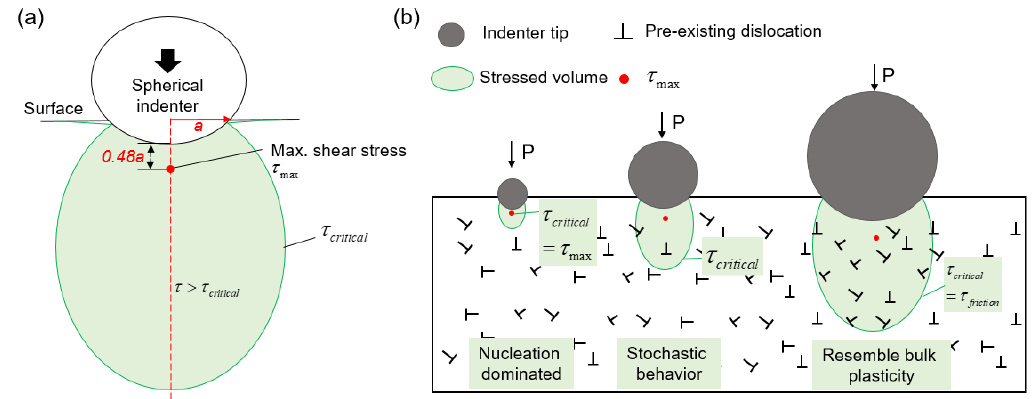
Figure 6. Schematic illustration of ( a ) the maximum shear stress and the critical shear stress under a spherical indenter; ( b ) effect of the defect population with respect to the volume being probed beneath the indenter tip, image modified based on [45]. Note that the critical shear stress is equal to the maximum shear stress when the stress volume is defect-free, so that homogeneous dislocation is activated. The complication of surface defects on heterogeneous dislocation nucleation is not included in this map.